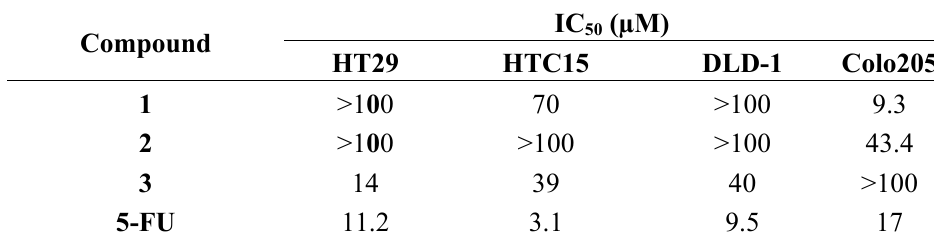
Table 2. The IC cytotoxicity of compounds 1 – 3 and 5-FU toward different colon cancer 50